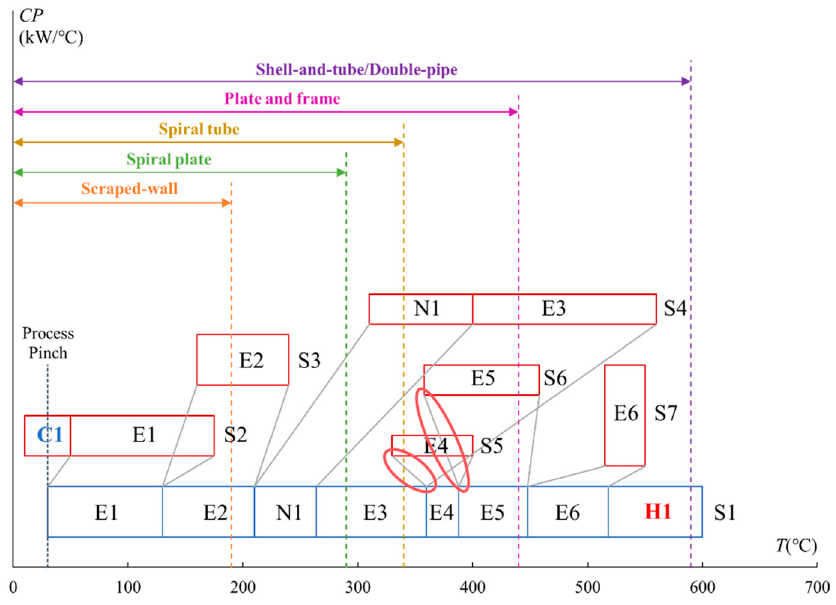
Figure 8. SRTGD-STR if the sequences of heat exchangers are not changed for the case